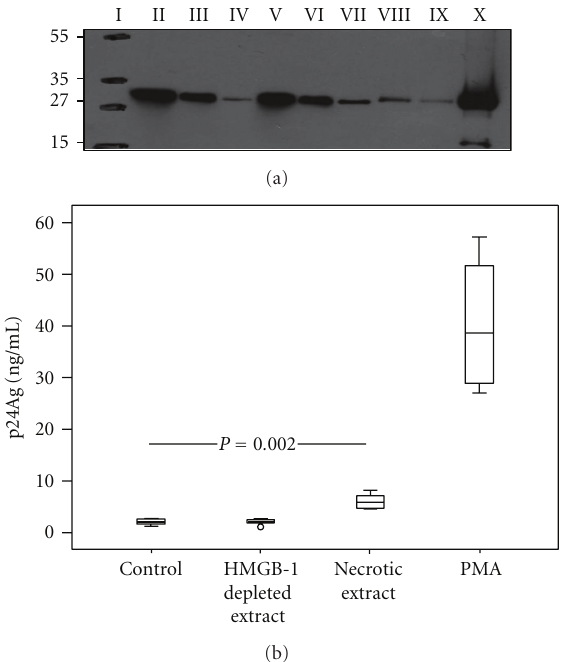
Figure 1: HMGB1 present in necrotic extract induces HIV-1 repli- cation in U1 cells. (a) Western blot of cell supernatants (necrotic extracts) obtained after freeze-thawing cycles of peripheral blood mononuclear cells (PBMC) (30 × 10 6 cells/mL) from healthy donors: Molecular weight marker (I); supernatants after immune depletion of HMGB1 with nonspecific rabbit polyclonal antibody (II); depletion with anti-HMGB1 antibody − 5 μ g (III) and 10 μ g (IV); necrotic extract loaded 20 μ L (V), 10 μ L (VI), and 5 μ L (VII); 100ng (VIII) and 75ng (IX) of recombinant HMGB1; cell debris (X). Numbers to the left depict positions of molecular mass markers (in kDa). (b) Levels of HIV p24 protein in cell culture supernatants after 72 h incubation of U1 cells with necrotic extract (HMGB1 concentration 1 μ g/mL): HMGB1-depleted necrotic extract and mock cells. PMA served as a positive control (20nM). The levels of viral replication were approximately 2-fold higher after stimulation by necrotic extract compared to the mock cells ( P = 0 . 002). Results from three independent experiments in duplicates are